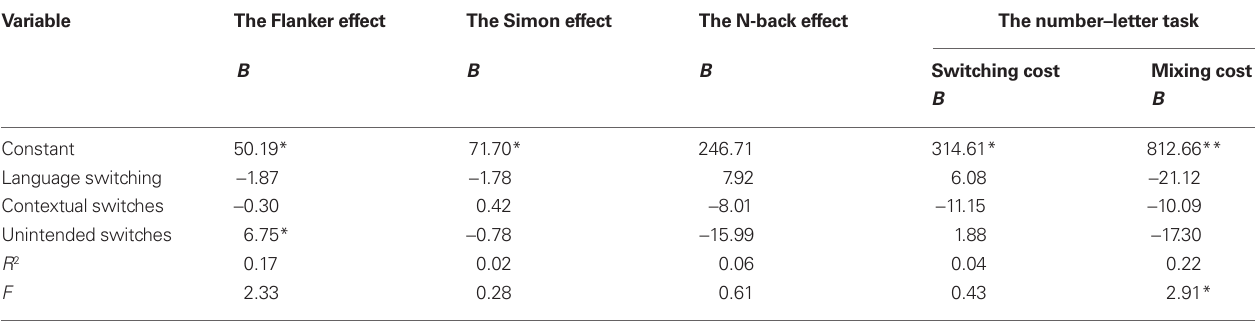
Table 6 | Summary of the multiple regression analyses: BSWQ variables as predictors of processing cost in RTs on the executive